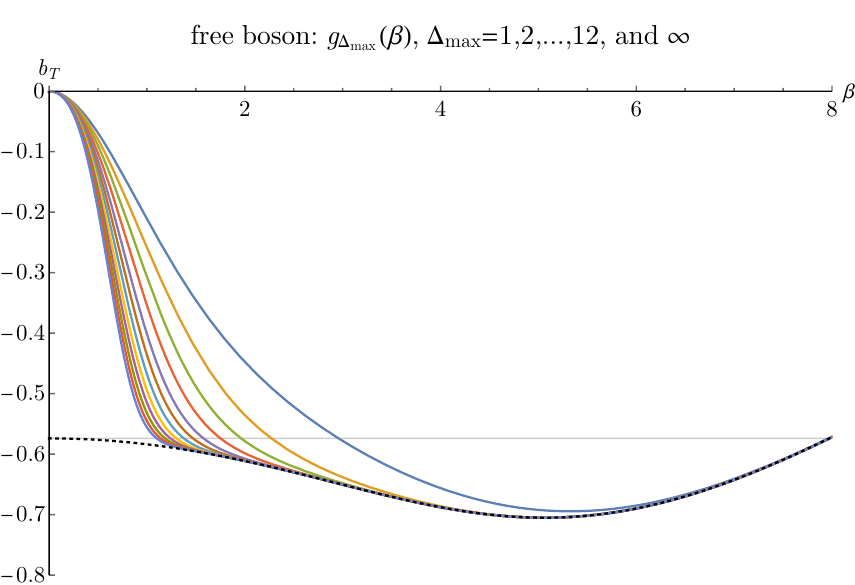
Figure 12. The function g (cid:1) ( (cid:12) ) in the free boson theory in 3d, plotted for the values (cid:1) max = max 1 ; 2 ; : : : ; 12 (colors), and (cid:1) max = 1 (black dotted line). The value of b T in the free theory (gray horizontal line) is (cid:0) 3 (cid:16) (3) (cid:25) (cid:0) 0 : 574. 2 (cid:25)